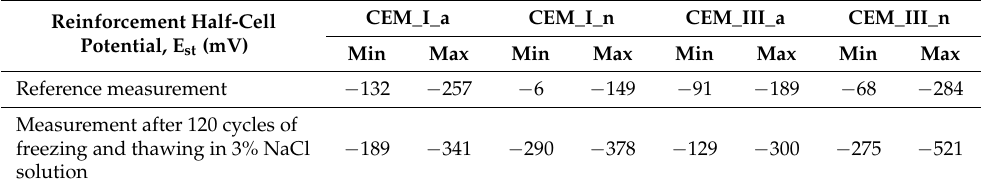
Table 4. Minimum and maximum values of reinforcement half-cell potential obtained from measure- ments before and after cycles of freezing and thawing specimens in a 3% NaCl solution.